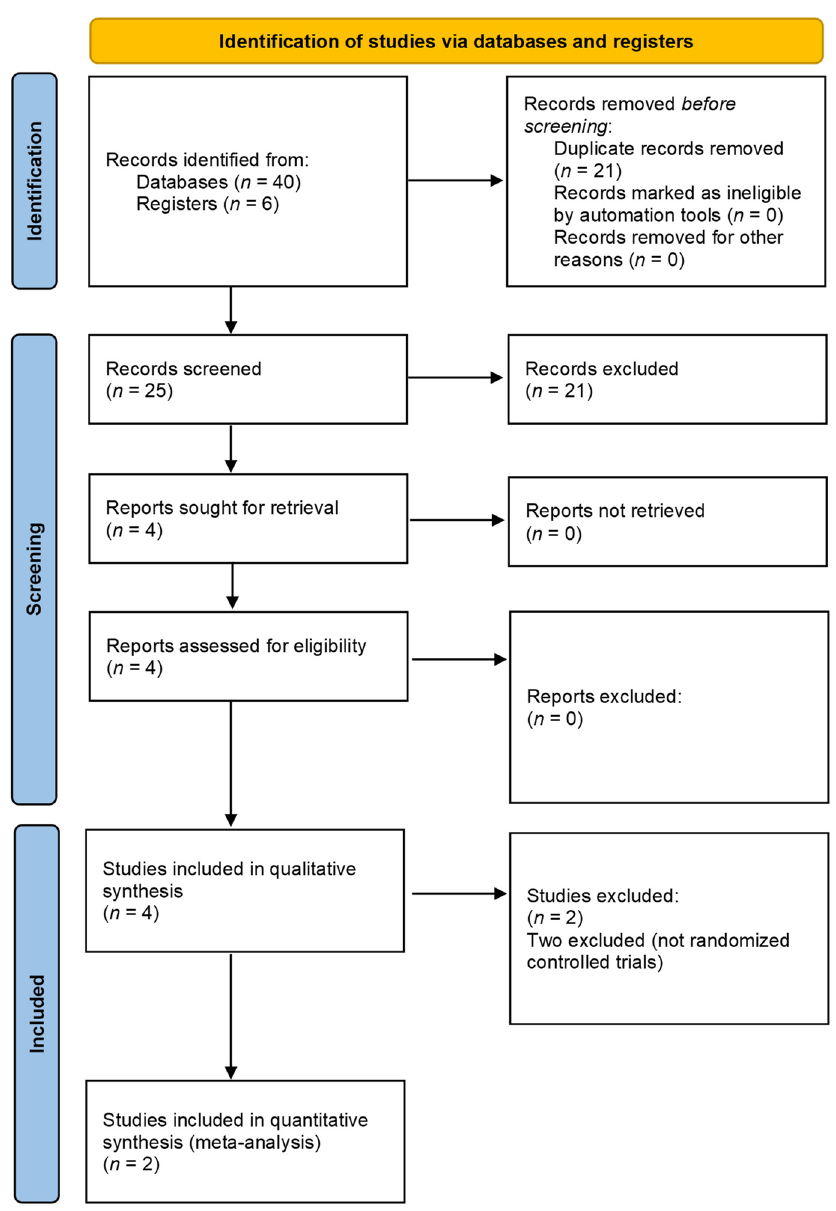
Figure 1. Literature screening process and results. Among the four included studies, Nahab et al. [23] injected onabotulinumtoxinA to the quadriceps femoris (40 units), tibialis anterior (20 units), gastrocnemius (20 units), and soleus (10 units). Agarwal et al. [18] had 50 units of onabotulinumtoxinA injected into the tibialis anterior in each leg. Mittal et al. [19] injected incobotulinumtoxinA into the tibialis an- terior (40 units), gastrocnemius (40 units), and biceps femoris (20 units). Ghorayeb et al. [22] injected intradermally into symptomatic areas (see Table 2 for further